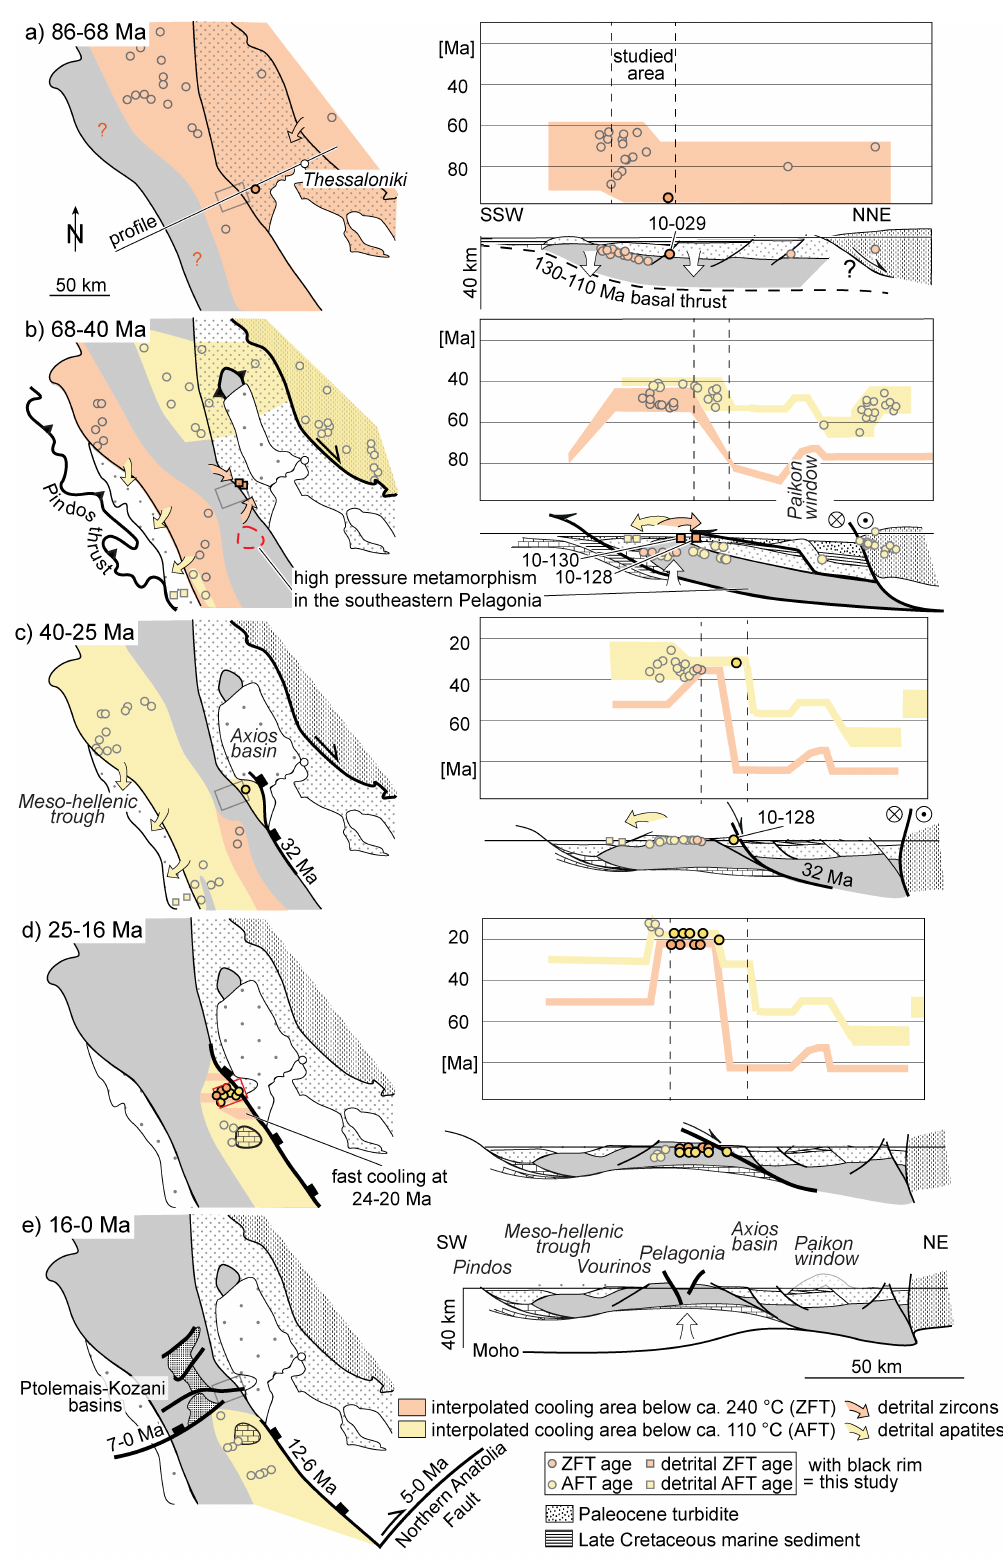
Figure 11. ZFT and AFT thermal history of Pelagonia from the Late Cretaceous onwards with restored profiles. ZHe and AHe ages neglected since they are not homogeneously distributed in the area. Unit patterns are identical to Fig. 1. Conceptual cooling patterns along thrust sheets are taken from Lock and Willett (2008). Until ca. 32Ma, cooling is homogeneous and parallel to the NW-SE tectonic contacts.